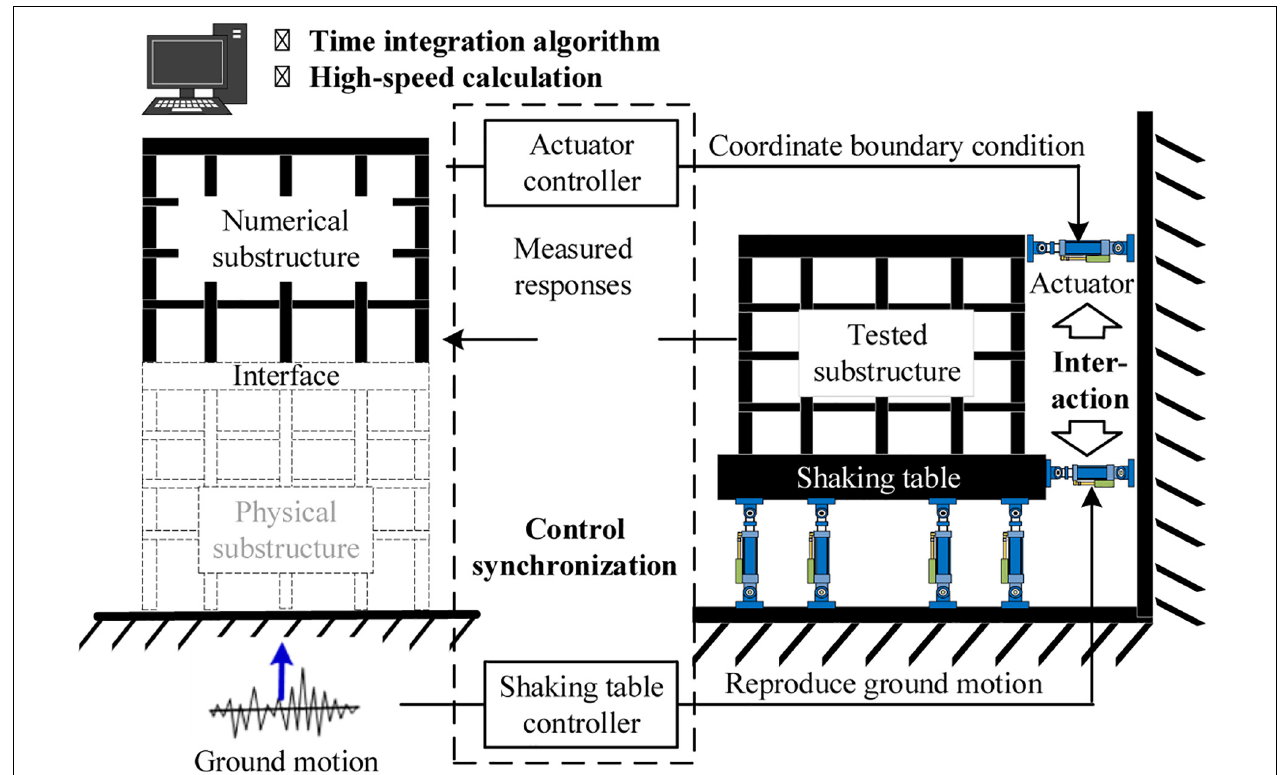
FIGURE 1 | Concept of shaking table substructure